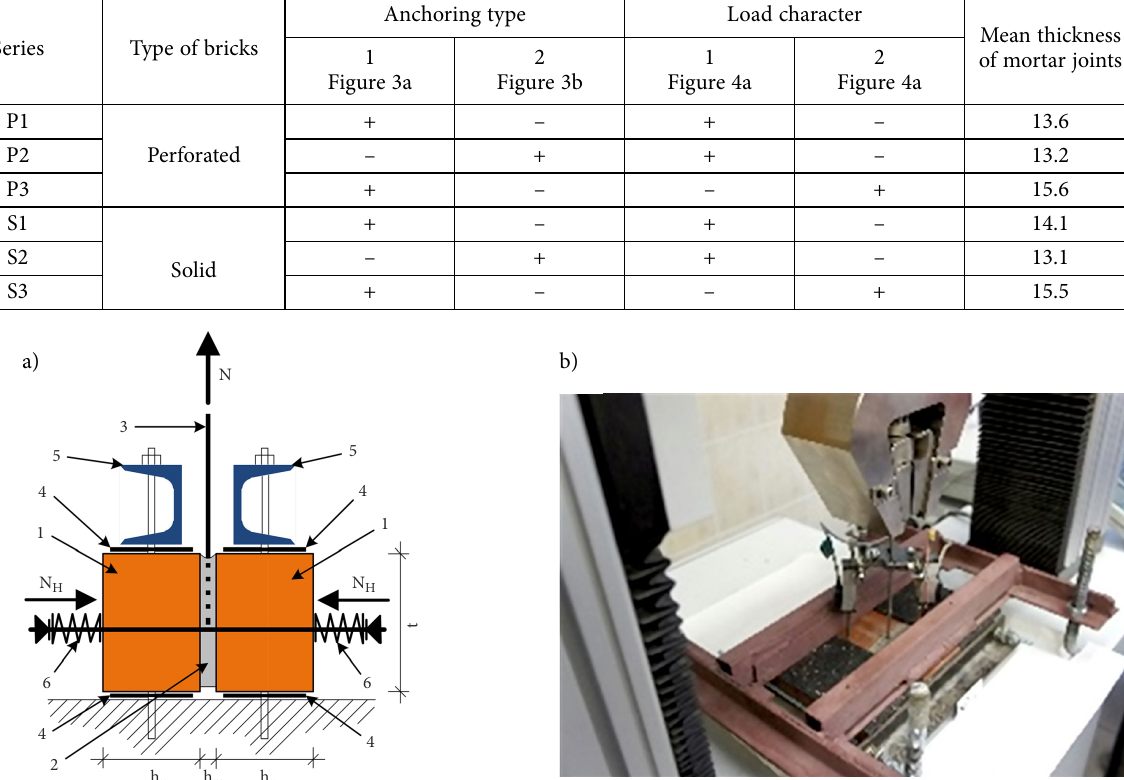
Figure 5. Scheme of the test and overall view: a – scheme, b – general view; 1 – ceramic bricks, 2 – mortar joint, 3 – flexible tie, 4 – rubber seam, 5 – frame, 6 – steel rod with